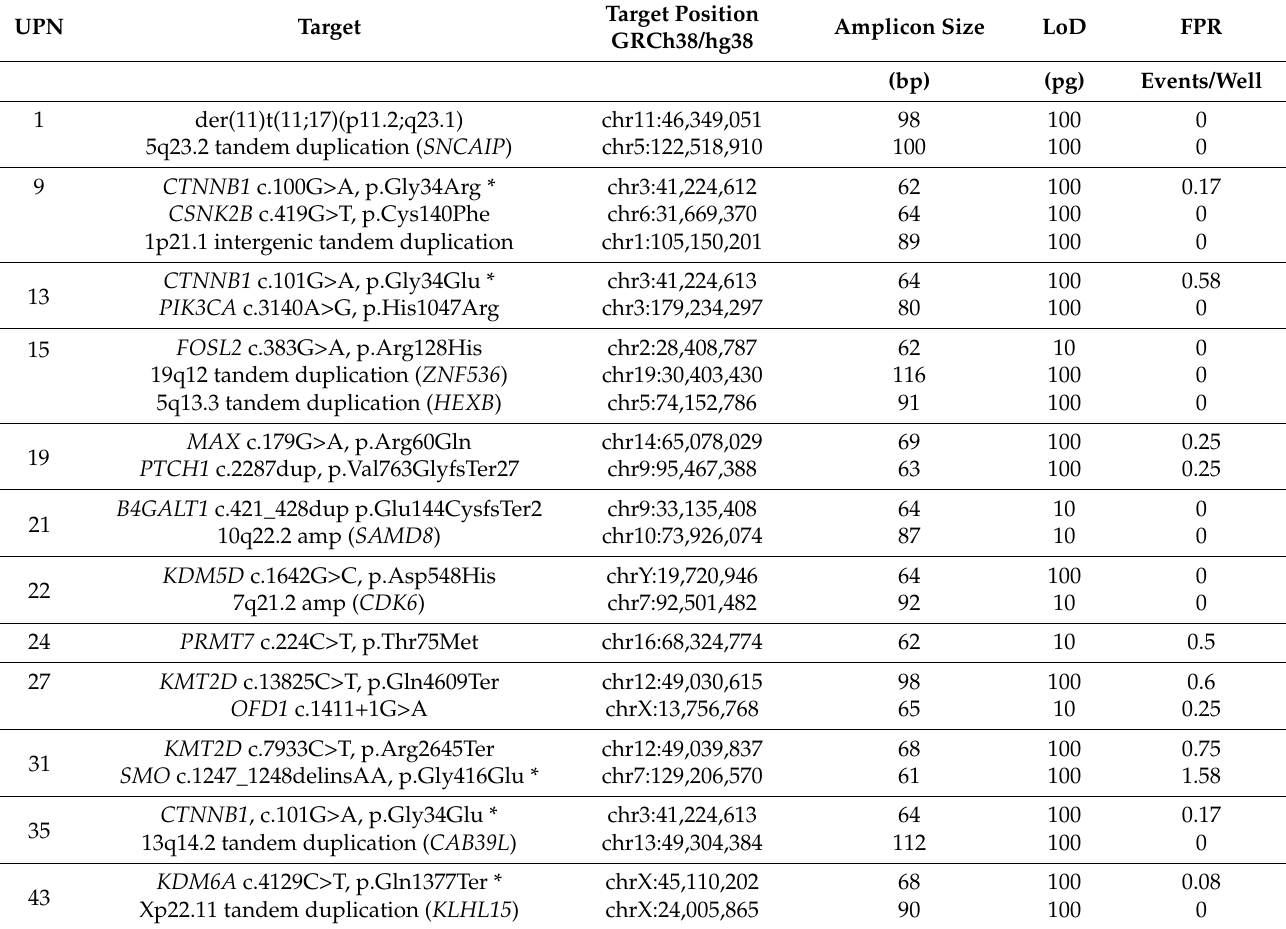
Table 2. ddPCR assays and limit of detection on genomic tumor